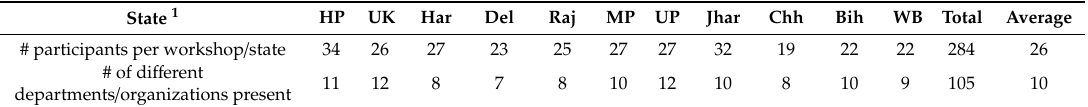
Table 4. Participation of stakeholder organizations in state-level participatory modelling workshops, July–October 2016.